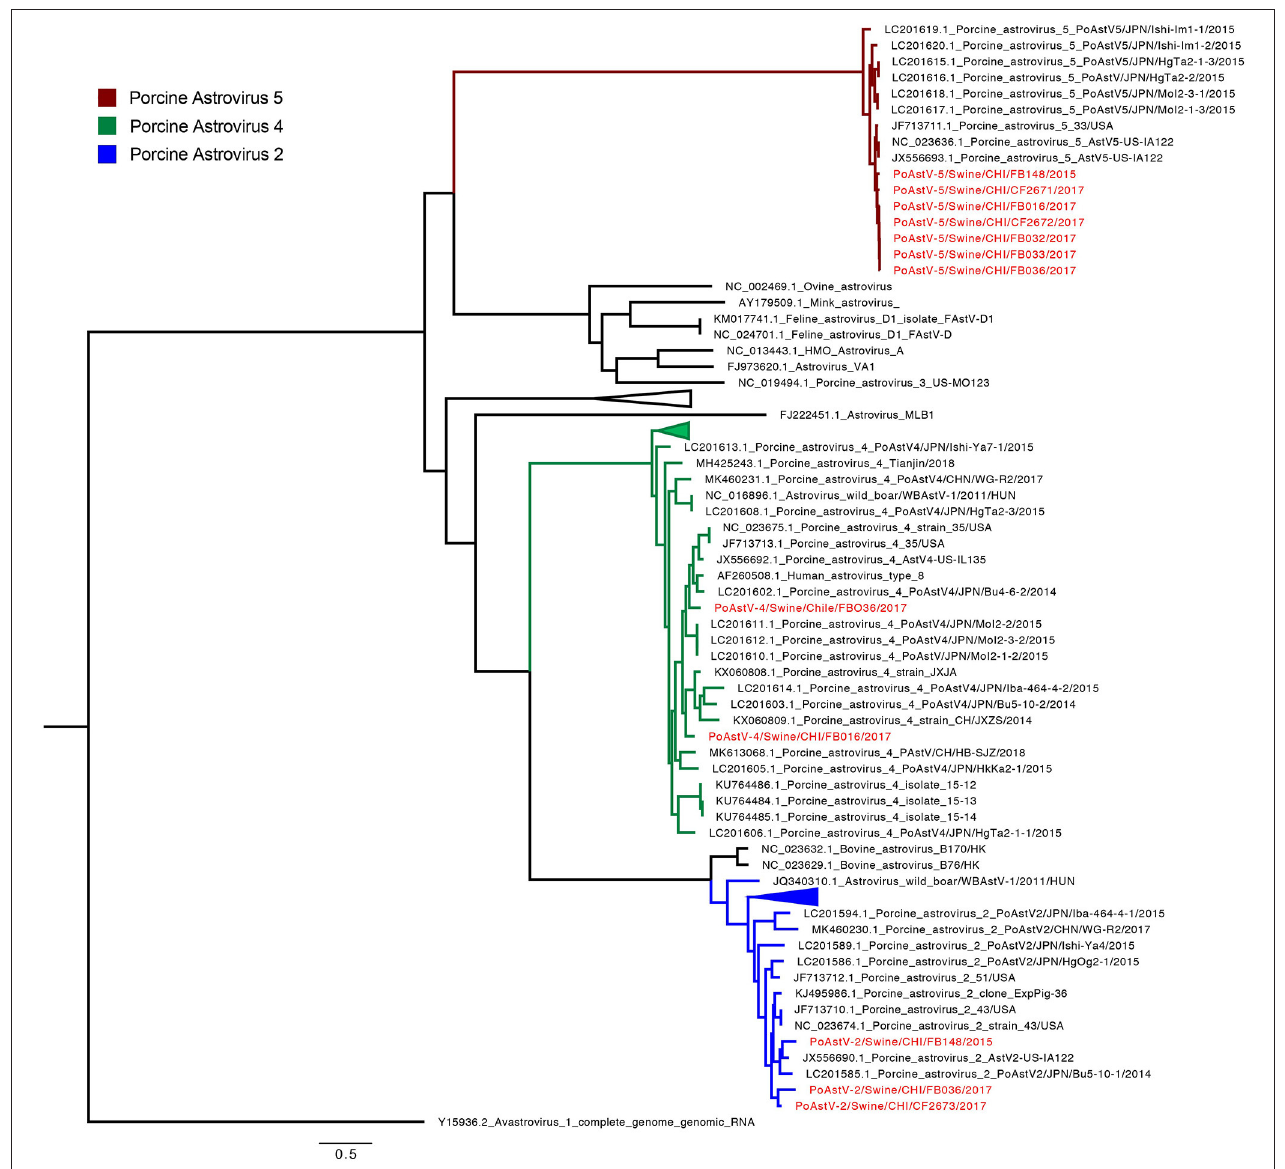
FIGURE 2 | Phylogenetic tree of PoAstV by using the complete genome. The final dataset included 93 genomes. Chilean sequences are highlighted in red. Clusters by species are highlighted in colors: PoAstV-5 (Red), PoAstV-4 (Green) and PoAstV-2 (Blue).